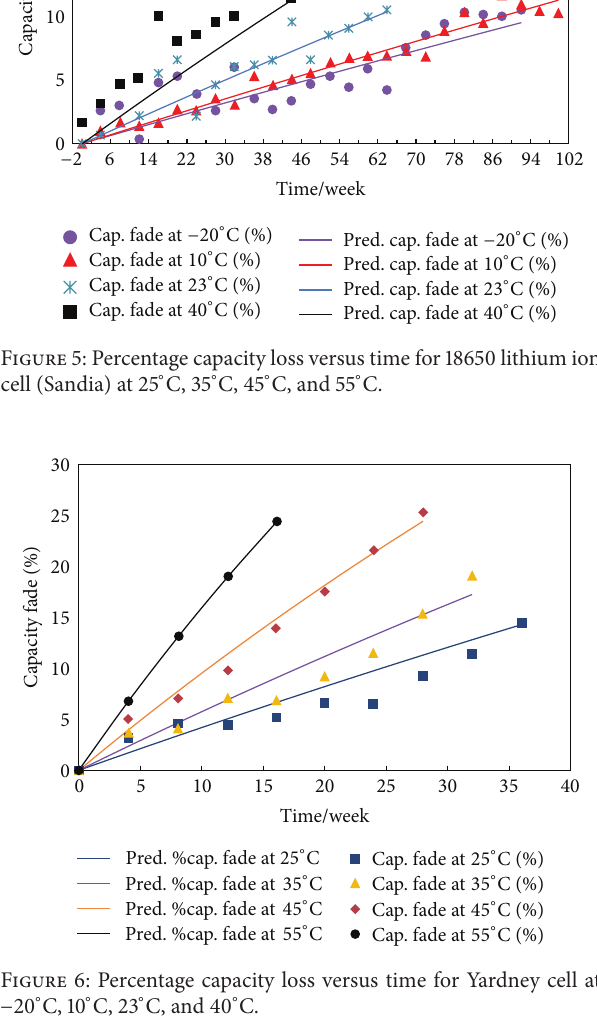
activation energy for the degradation process varies from 35 KJ/mol to 50 KJ/mol which approximates our